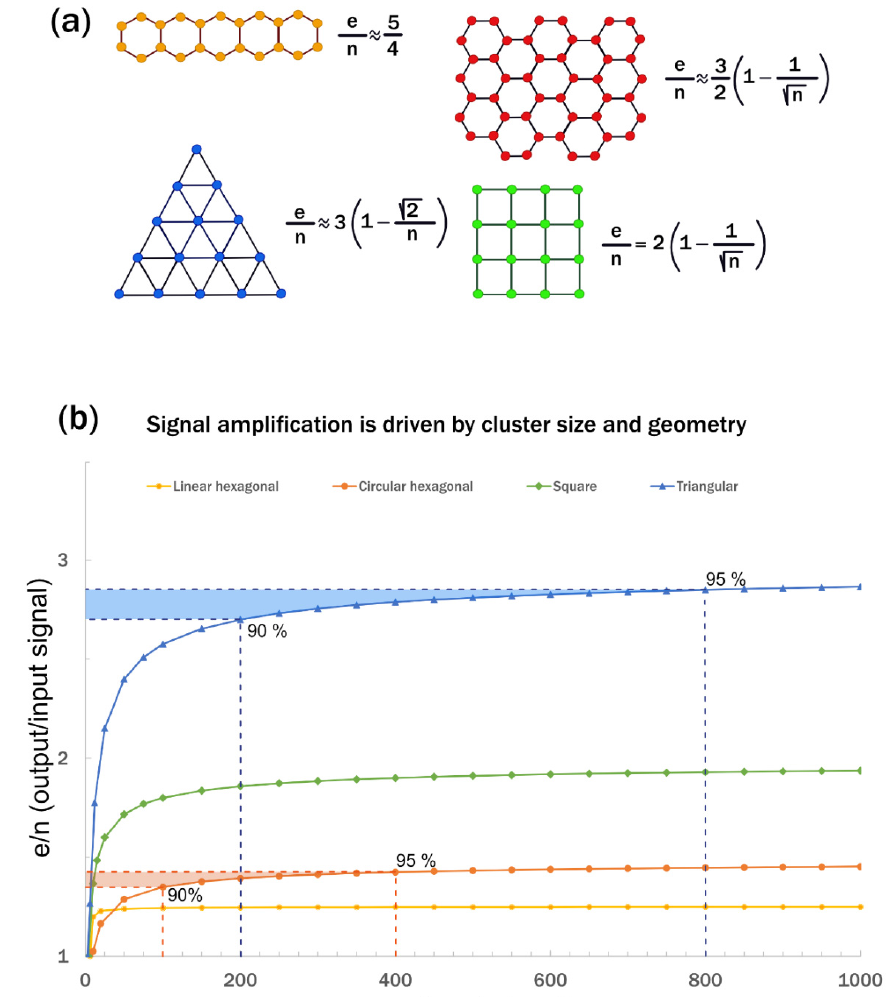
Figure 2. Illustration of Euler’s formula for 2D polygons. ( a ) The e/n ratio is calculated for several examples of regular tiled polygons. ( b ) The e/n ratio plotted against n for the tiled polygonal systems shown in ( a ). It represents signal amplification and reaches its maximum level with tiled triangles but can never exceed 3. A 90% maximum signal amplification can be achieved with a cluster of ~100 signaling units in a hexagonal cluster depending on geometry, but the same level of amplification requires a cluster of ~200 signaling units in a triangular cluster. Calculations are provided in Appendix A.